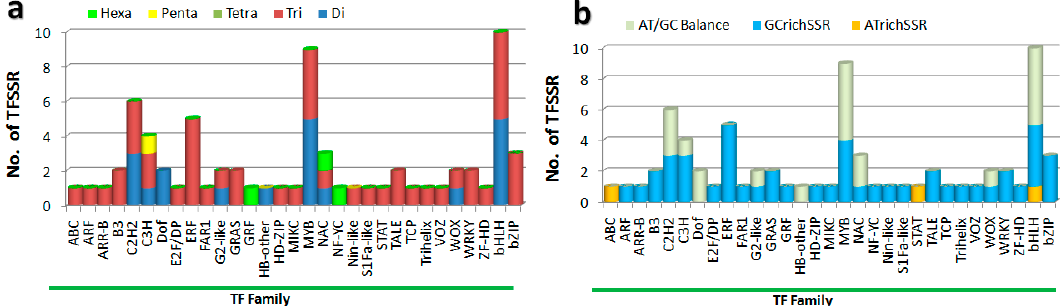
Figure 1. Distribution of TFSSRs in different TF family genes. ( a ) Distribution by family in terms of repeat unit size; ( b ) Distribution by family in terms of motif nucleotide base composition.